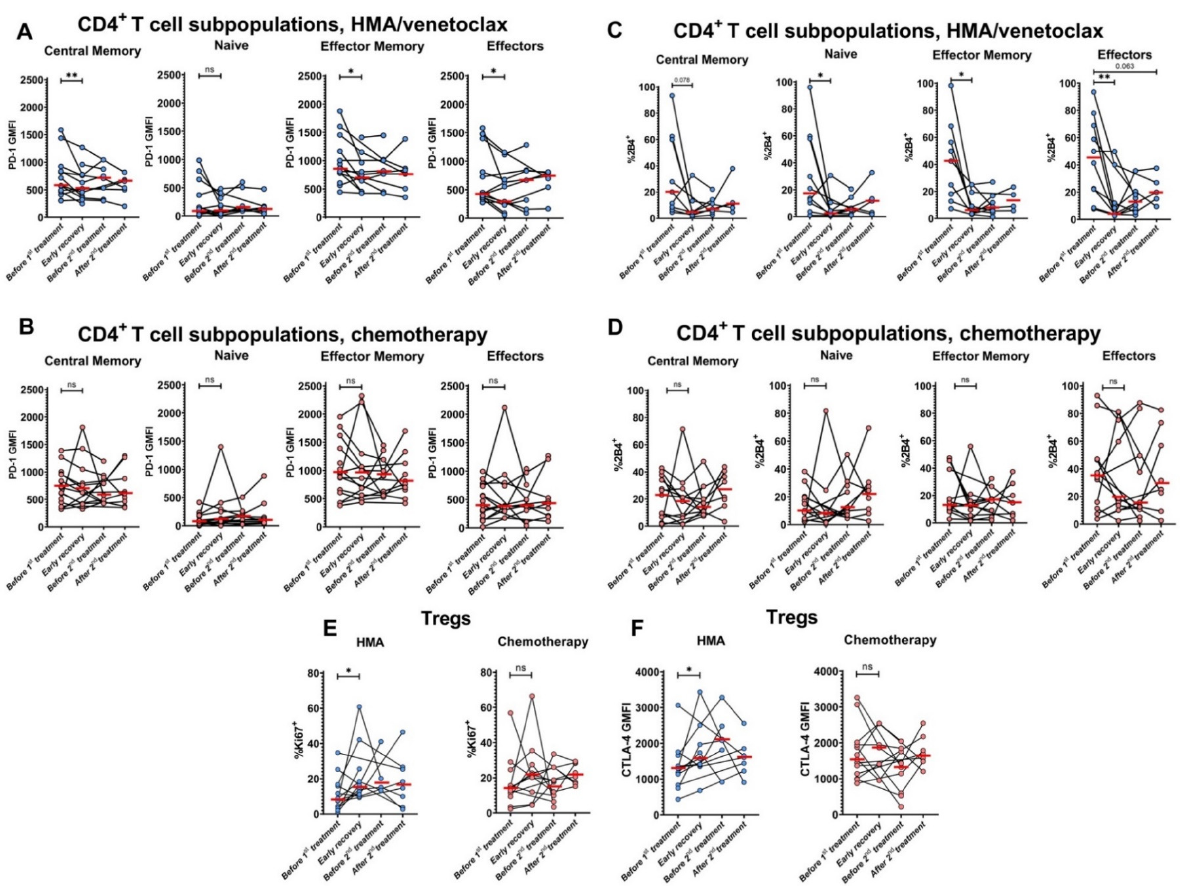
Figure 5. Initial course of HMA/venetoclax treatment reduces expression of checkpoint molecules PD-1 and 2B4 and enhances Treg proliferation and CTLA-4 expression. GMFI of PD-1 expression on CD4 + T cell subpopulations during treatment with HMA/venetoclax ( A ) or IC ( B ). ( C , D ) The changes in % CD4 + T cell subpopulations expressing 2B4 when treated with HMA/venetoclax ( C ) or IC ( D ). ( E ) Dynamics of the proportions of Ki67 + Tregs during the treatments. ( F ) GMFI of CTLA-4 expression on Tregs during the treatments. Red bars represent medians. Data are from patients with >1 sample collected. Blue circles are HMA/venetoclax, and pink circles are chemotherapy. Wilcoxon signed-rank test was used for statistical analysis. ns— p > 0.05; *— p < 0.05; **— p < 0.01. Actual p-value is specified in cases when it is close to